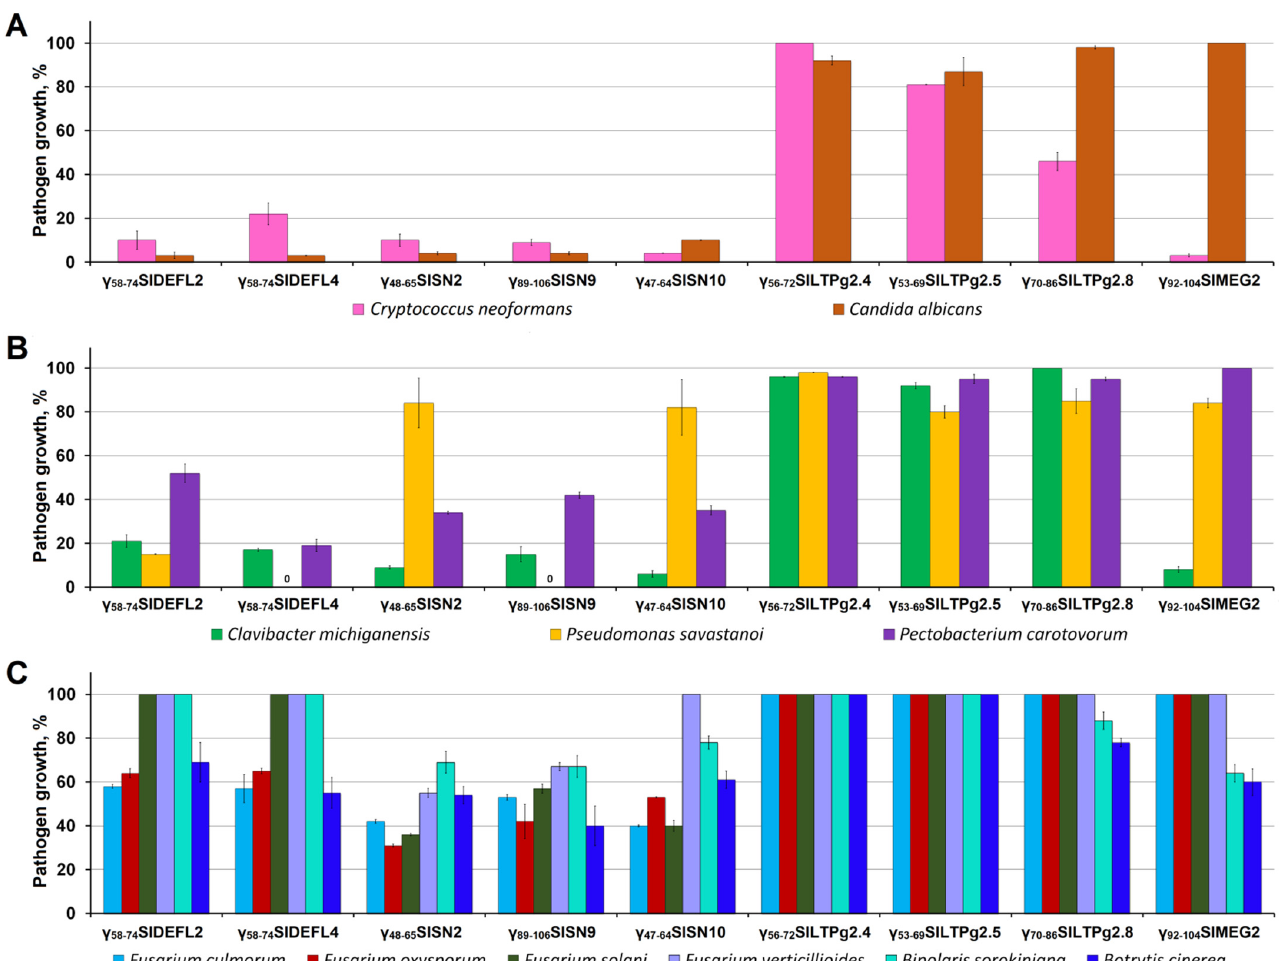
Figure 3. Growth of pathogens in the presence of synthetic peptides (300 µM): ( A ) yeasts, ( B ) bacteria, ( C ) plant pathogenic fungi. Bars represent mean ± SD of growth compared to control (pathogen growth in the absence of peptide).